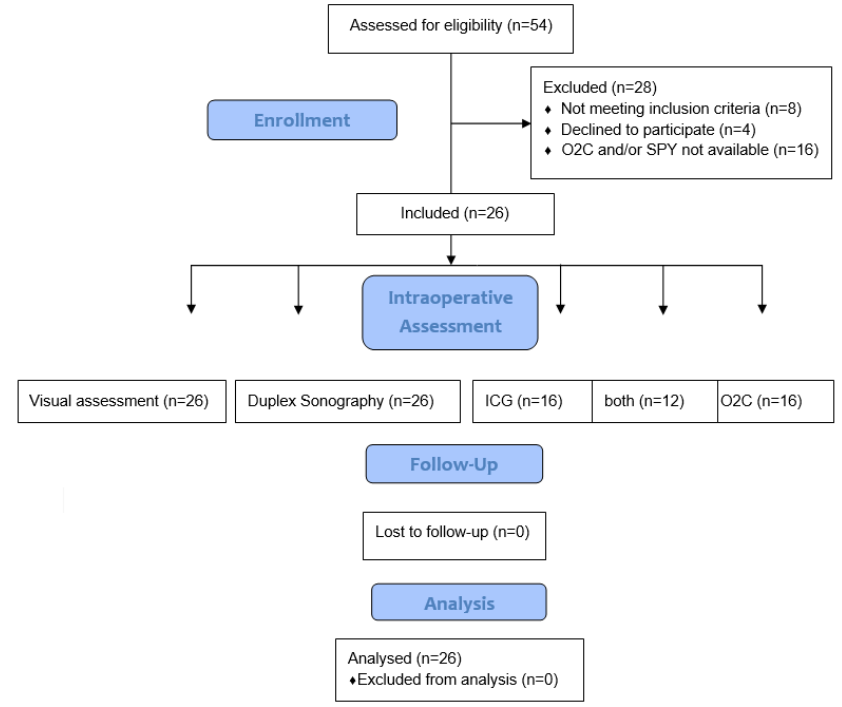
Figure 1. Flow Figure 1. Flow diagram.